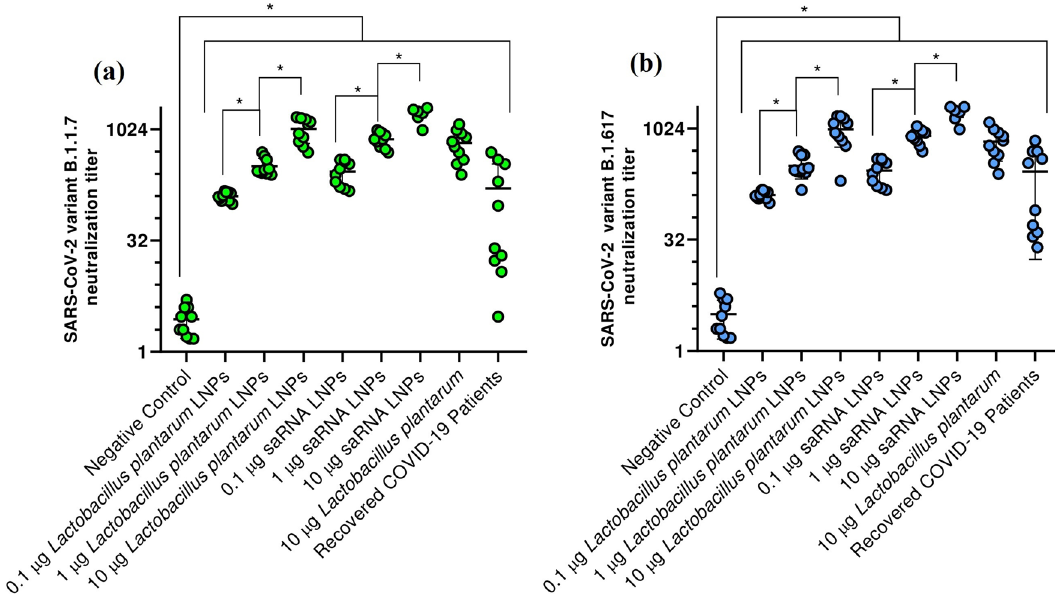
Figure 3. The viral neutralization titer against SARS-CoV-2 variants B.1.1.7 ( a ) and B.1.617 ( b ) in mice vaccinated with saRNA LNPs, transfected Lactobacillus plantarum LNPs, and transfected Lactobacillus plantarum alone and in recovered COVID-19 patients. * indicates significance difference with P < 0.05 using one-way ANOVA with n = 10 biologically independent mice and n = 10 recovered COVID-19 patients. All data were shown as mean ± SD.